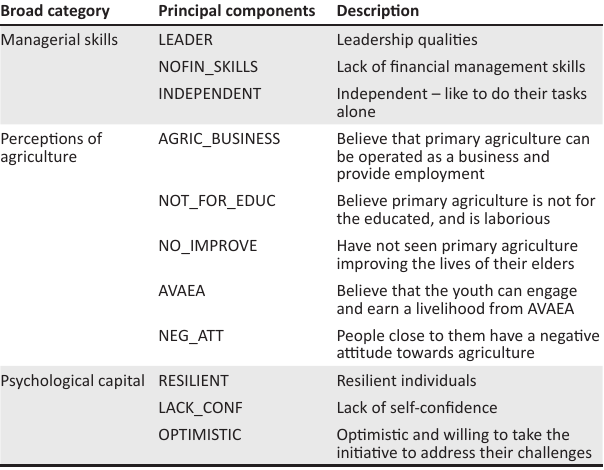
TABLE 1: Indicators for managerial skills, perceptions and psychological capital. Broad category Principal components Description Managerial skills